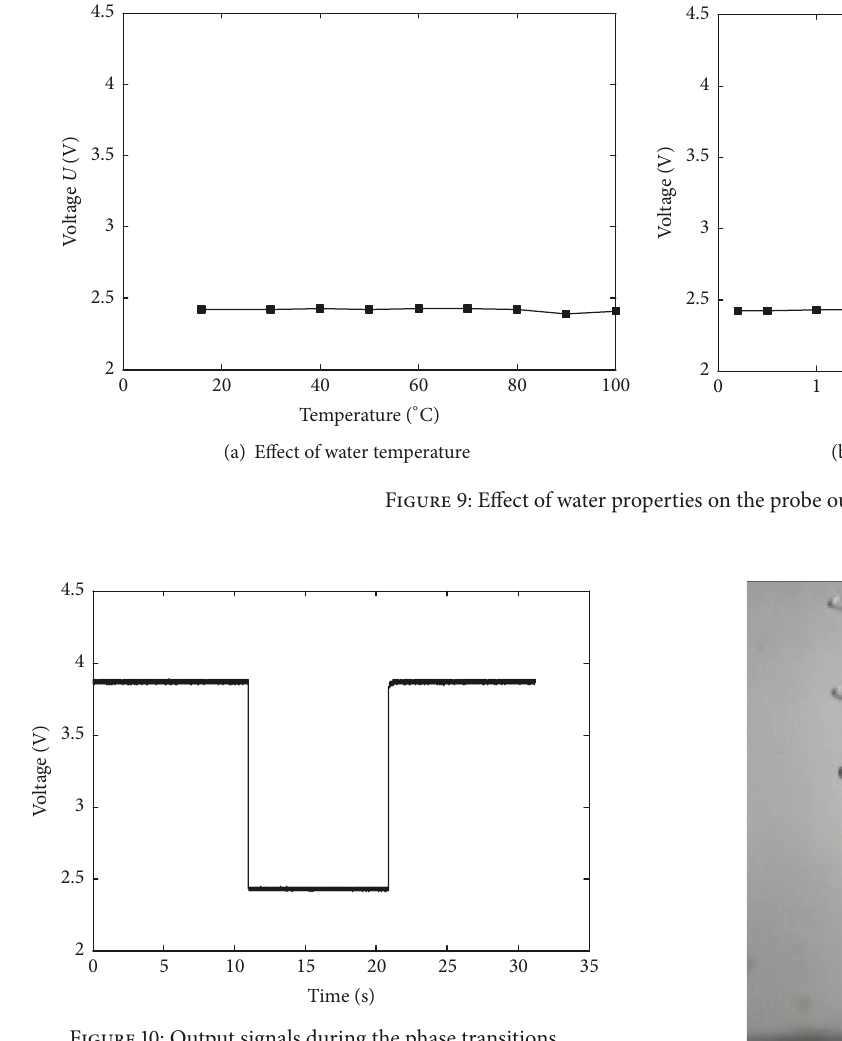
Figure 10: Output signals during the phase transitions.